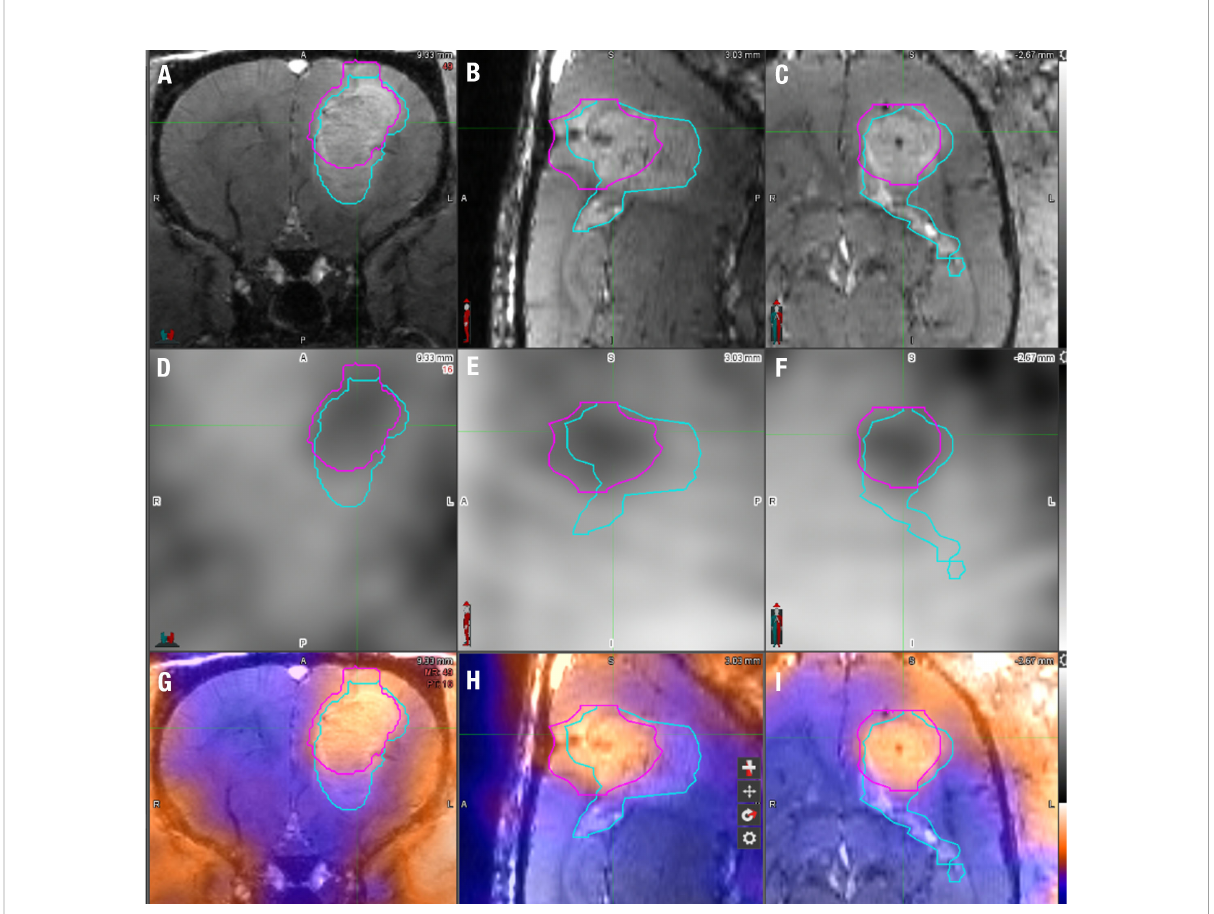
FIGURE 2 18 F-FET PET/MRI analysis technique using MIM7 software. (A – C) The upper row displays the T1 FLASH post-contrast imaging in coronal, sagittal, and horizontal planes from left to right. (D – F) The middle row displays 18 F-FET PET images of the same animal in the same coronal, sagittal, and horizontal planes. (G – I) The bottom row displays the fusion of the T1 FLASH contrast-enhanced sequence and 18 F-FET PET image for the same animal. The light blue line represents the manual VOI drawn around the contrast-enhanced portion of the image around the tumor, and the pink VOI represents the 18 F-FET PET activity, each superimposed on the images. The tumor volume was derived from the MRI VOI, while the % of the injected dose/mL (%ID/cc) and tumor-to-brain ratio (TBR) were derived from the 18 F-FET PET